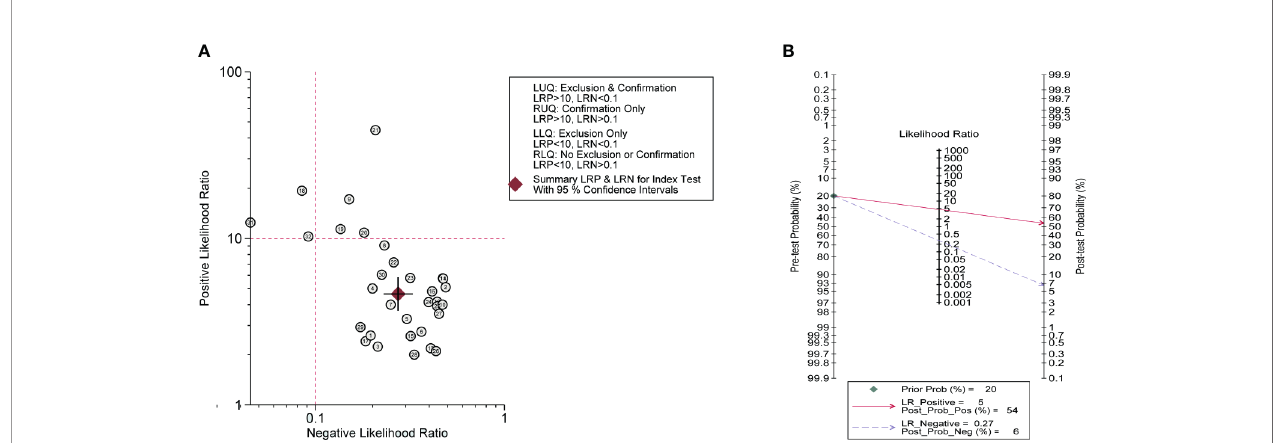
FIGURE 4 | Clinical utility of circulating miRNAs. (A) Summary LRP & LRN for Index Test showed that a few miRNAs (No. 9/18/19/20/21/31/32) had relatively good clinical diagnostic value. LLQ, left lower quadrant; LRN, likelihood ratio negative; LRP, likelihood ratio positive; LUQ, left upper quadrant; RLQ, right lower quadrant; RUQ, right upper quadrant; (B) Fagan nomogram of Pre-test probability and post-test